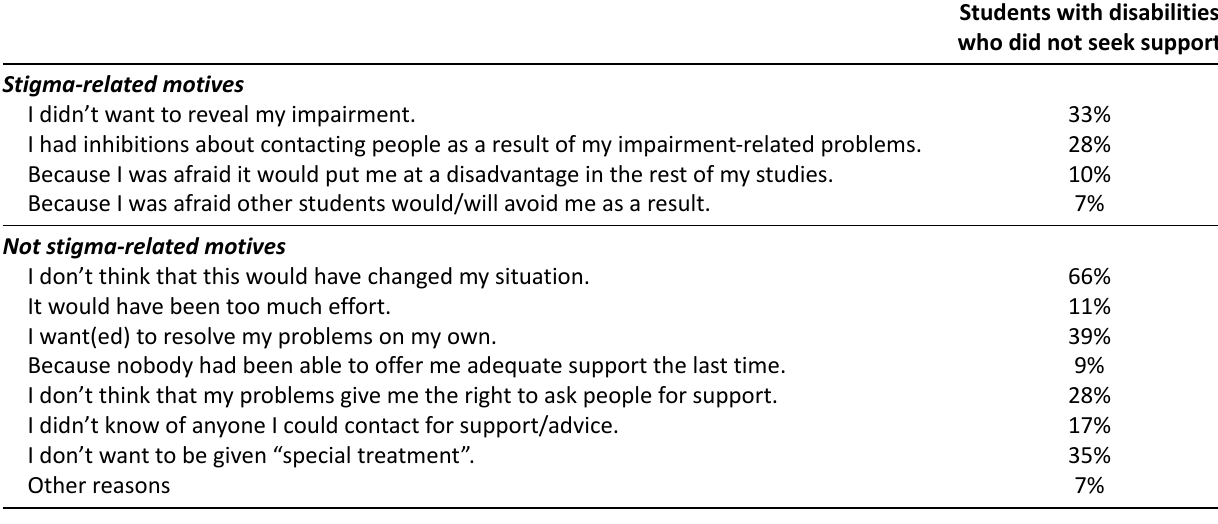
Table 1. Motives for not seeking support in case of disability-related difficulties in one’s studies. Source: Terzieva et al. (2016, p.